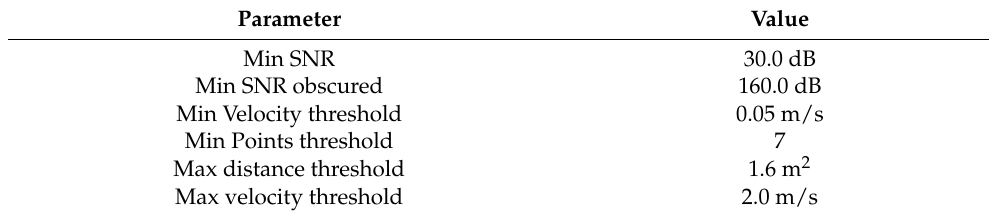
Table 3. GTRACK allocation parameters for pedestrian detection.